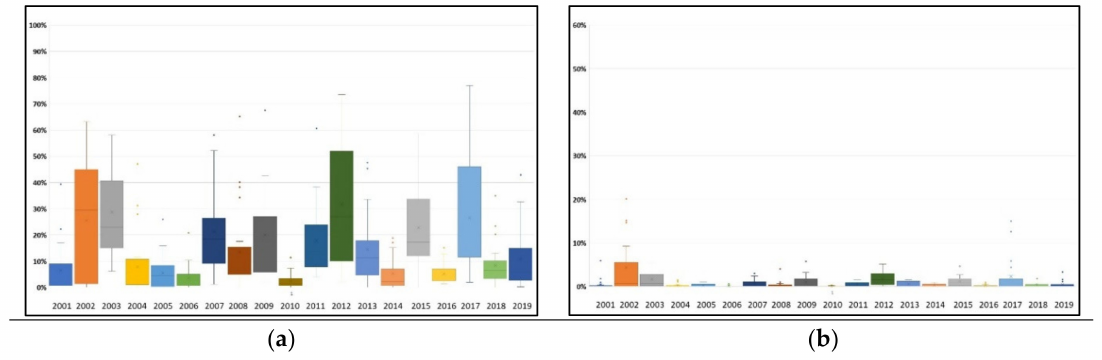
Figure 8. Box-plot type diagram of agriculture areas a ff ected: ( a ) by drought with di ff erent intensities and ( b ) by extreme drought, between 2001 and 2019 in Banat Plain. Number of samples for 2001 is 21 and for the other years the number of samples it is